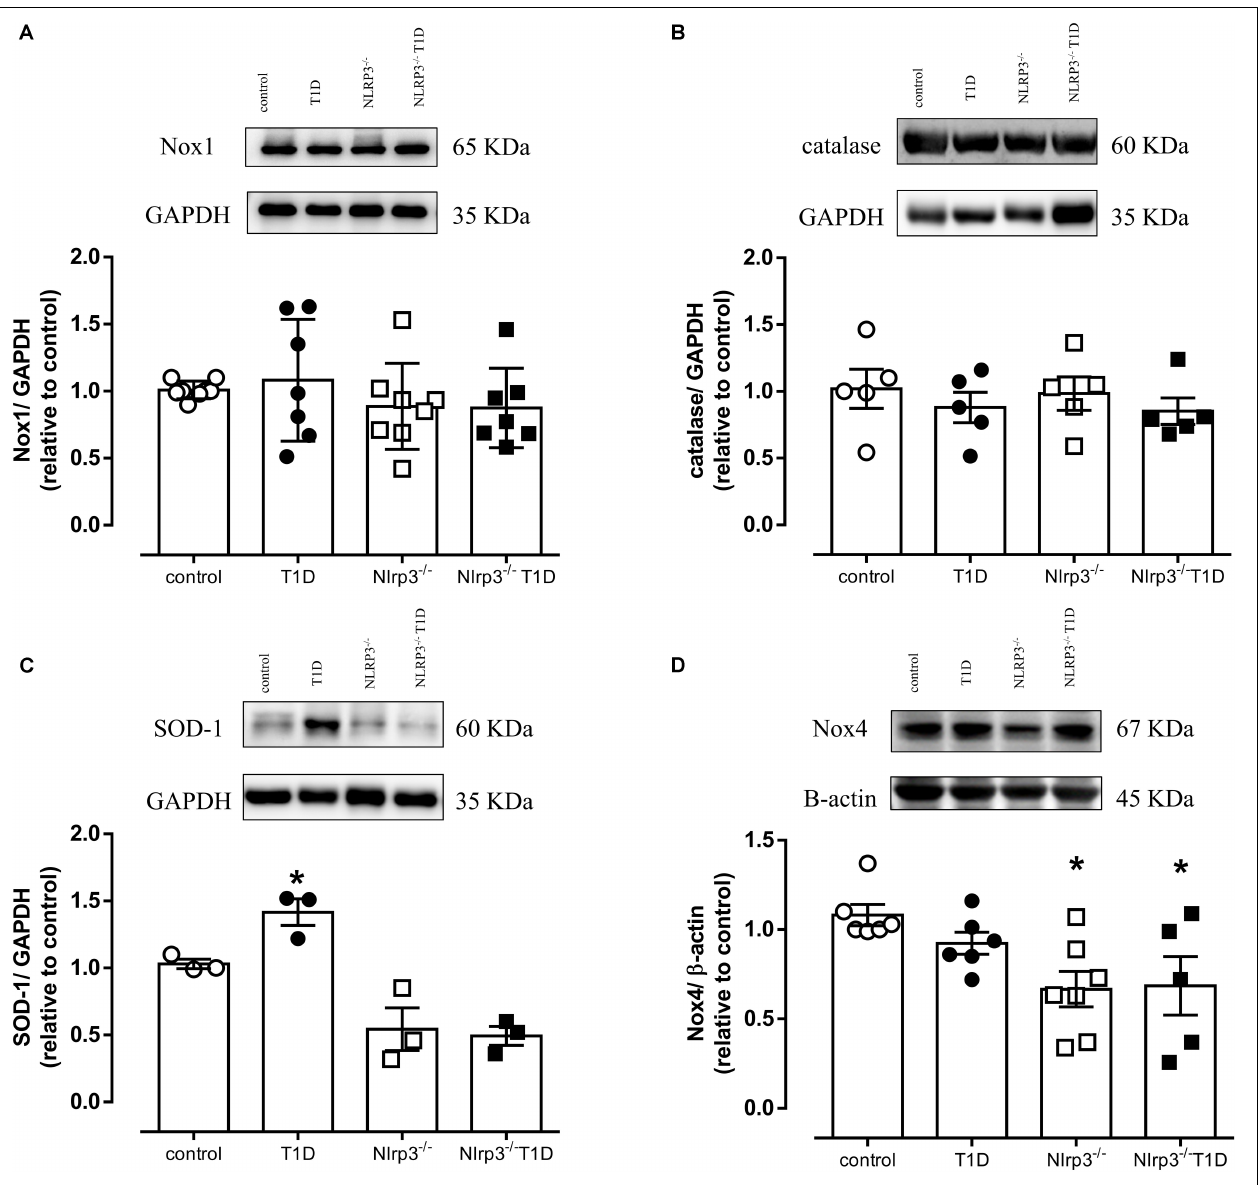
FIGURE 3 | On top, representative images of western blot and, at the bottom, densitometric analysis of the vascular expression of (A) Nox1, (B) Catalase, (C) SOD-1 and (D) Nox4 in mesenteric arteries from C57BL/6 non-diabetic (control, white circles) or diabetic (T1D, black circles) and Nlrp3 − / − non-diabetic ( Nlrp3 − / − , white squares) or diabetic ( Nlrp3 − / − T1D, black squares) mice. Each column represents the mean ± SEM. ∗ P < 0.05 vs. respective control. N = 3–7, two-way ANOVA followed by Tukey’s post hoc test (A–D)